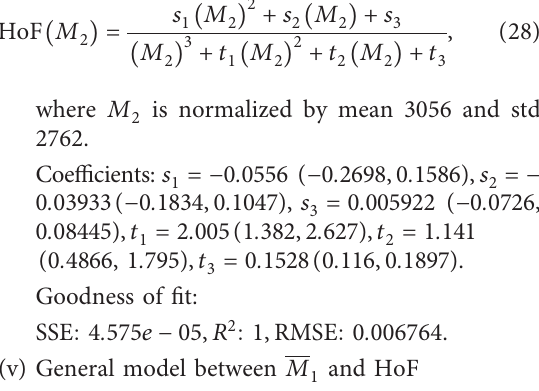
( G ) , M ( G ) , M ( G ) , and M 1 2 1